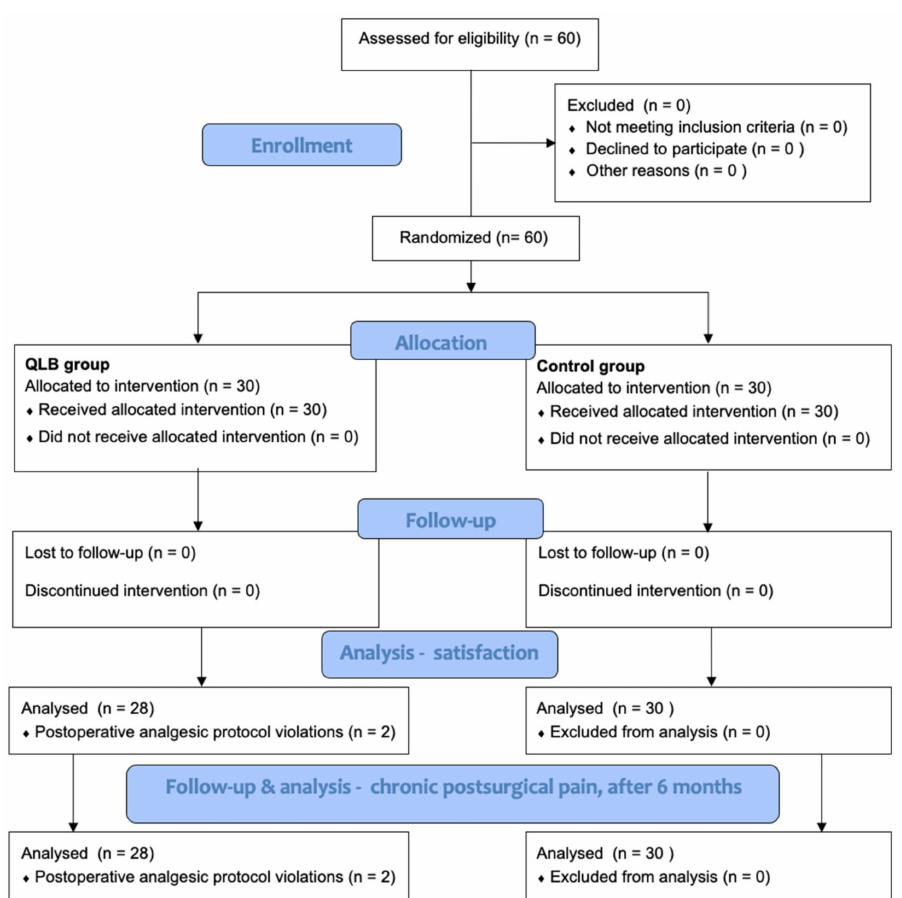
Figure 1. Study flowchart